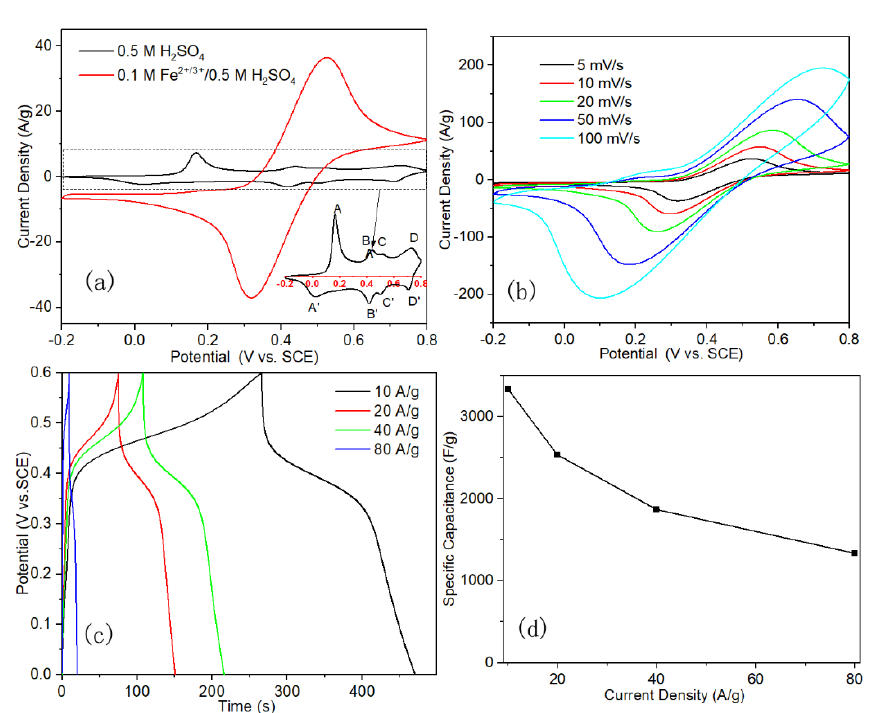
Figure 3. ( a ) Cyclic voltammetry (CV) curves of PANI/Ti electrode at 5 mV s − 1 in different electrolyte, inset is the magnified CV curve in 0.5 M H 2 SO 4 ; ( b ) CV, and ( c ) galvanostatic charge/discharge (GCD) curves of PANI/Ti electrode in 0.1 M Fe 2+/3+ /0.5 M H 2 SO 4 ; and, ( d ) the dependence of specific capacitance of PANI/Ti electrode in 0.1 M Fe 2+/3+ / 0.5 M H 2 SO 4 on the current density.